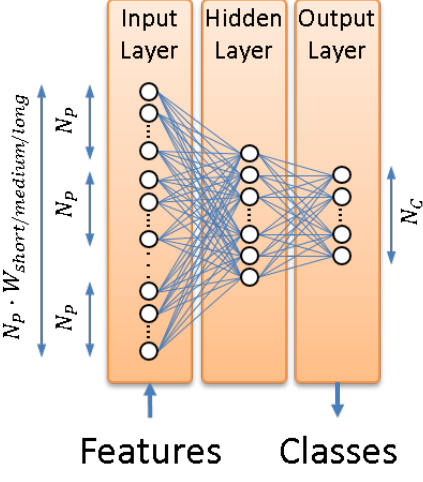
Figure 3. Architecture of the three-layer MLP employed in the contextual feature extraction module.